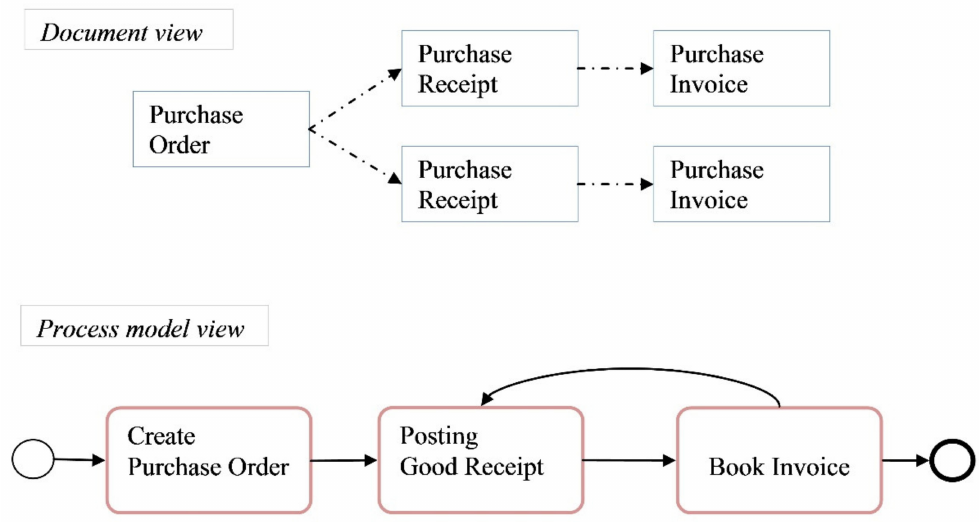
Figure 2. Data divergence problem as visualized from different views.